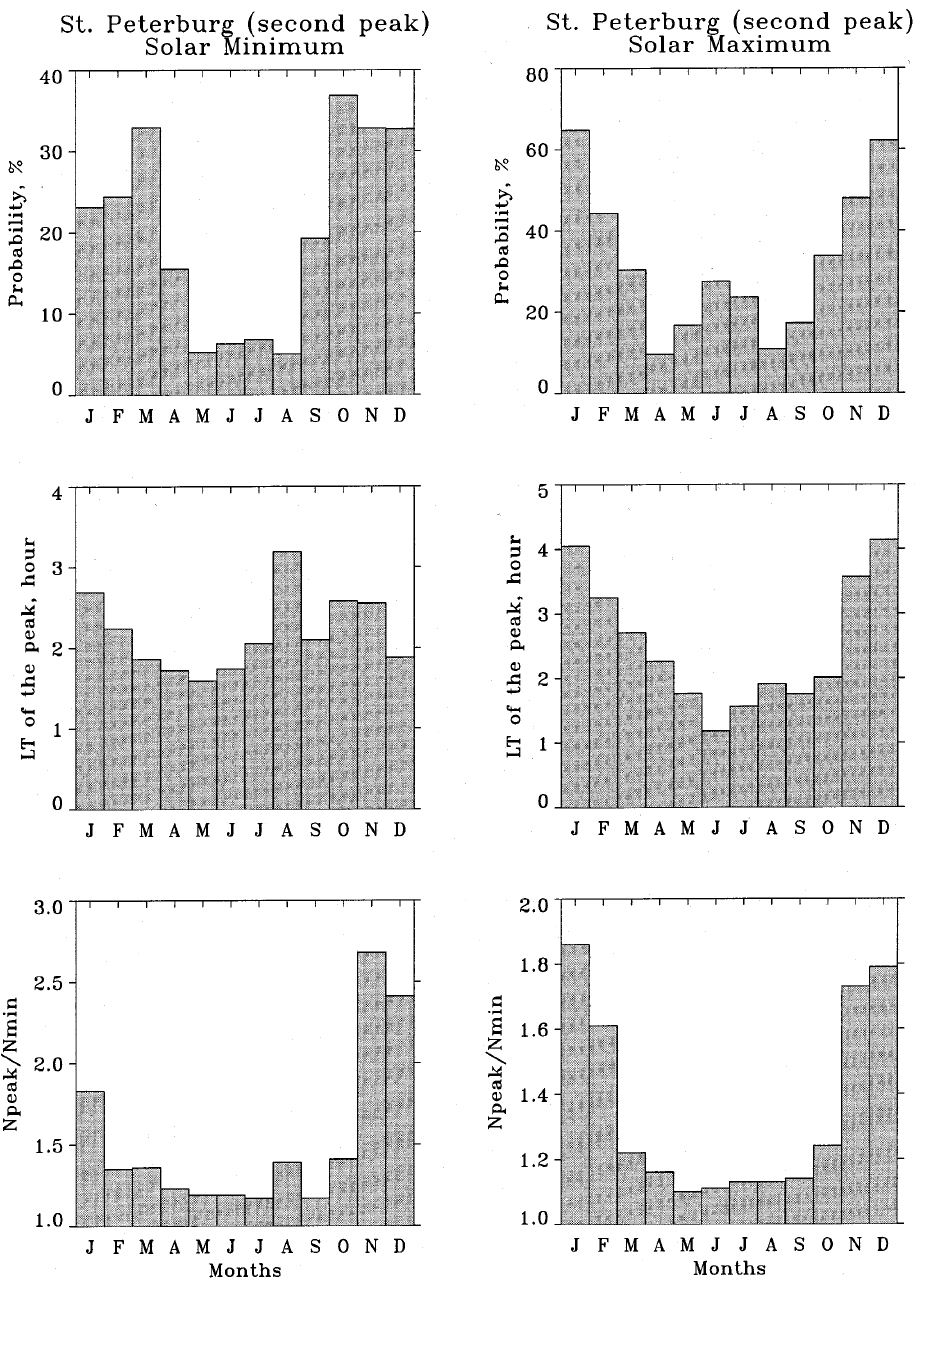
Fig. 5. Same as Fig. 4 but for the 2nd peak